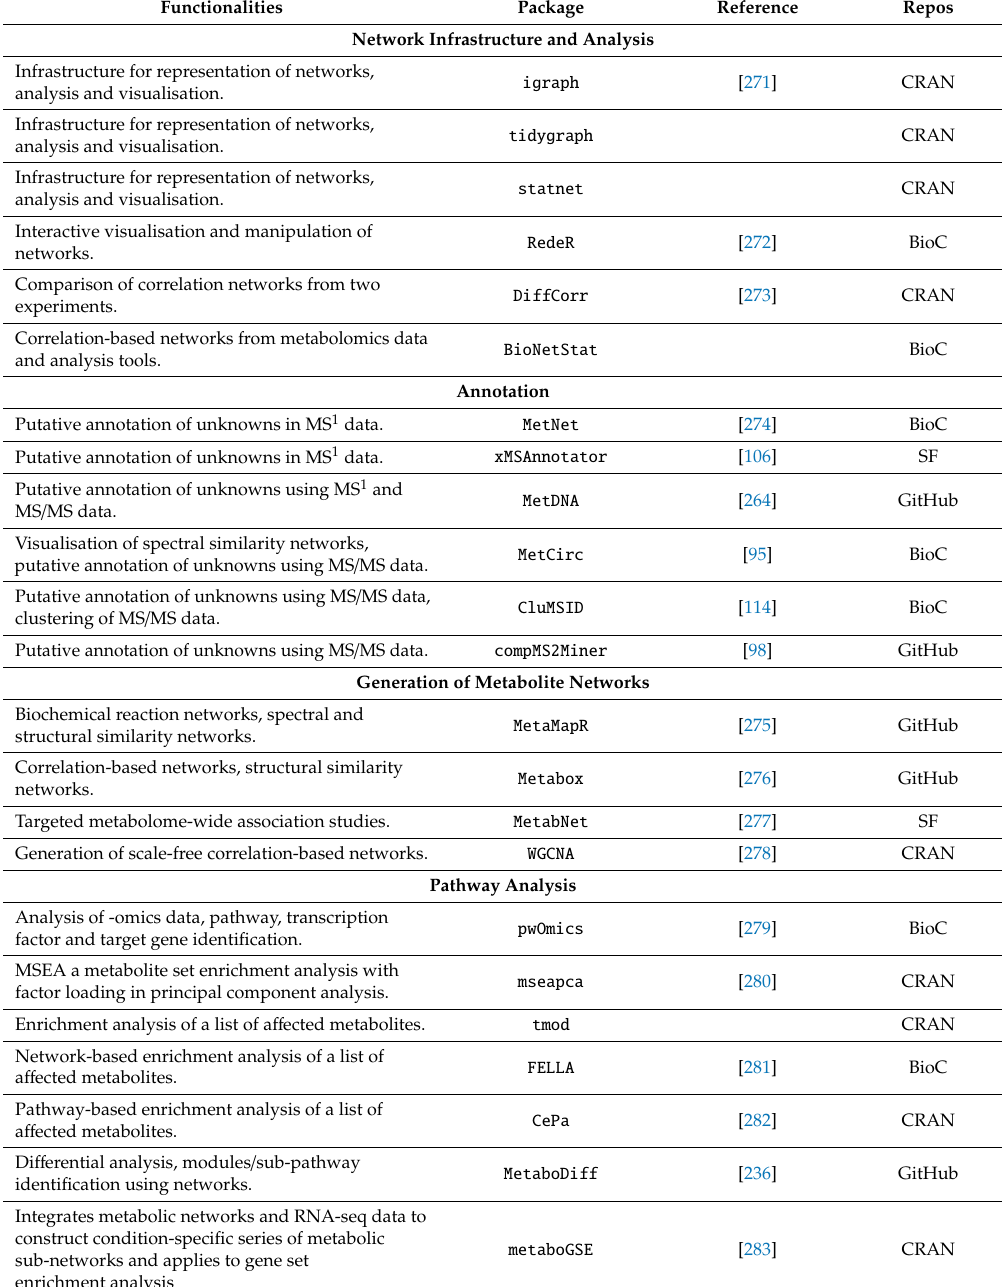
Table 8. R packages for network analysis and biochemical